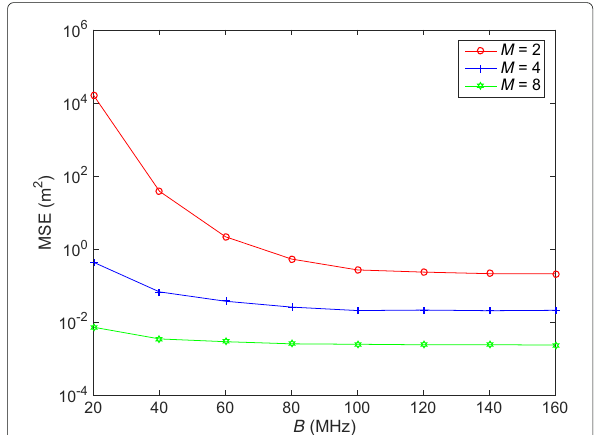
Fig. 3 Numerical result 1. MSE versus B with M as a parameter, for δ = 10ns, ρ = 0 dB, and N